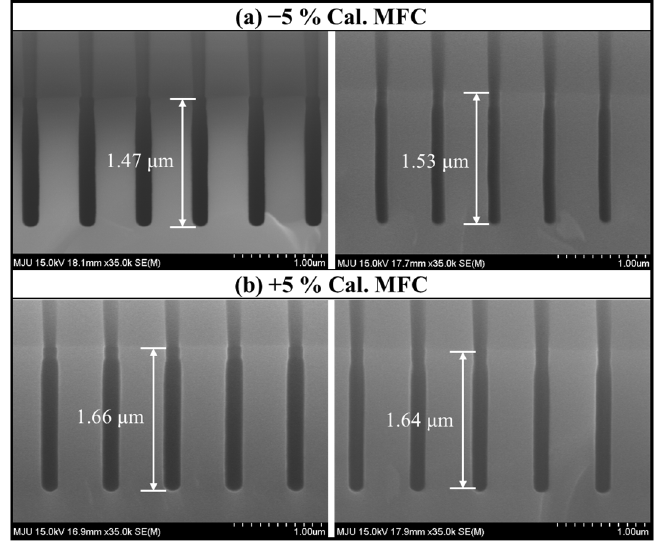
Figure 9. Cross-sectional SEM image of process results with the mis-calibrated MFC; ( a ) results with − 5% calibrated MFC and ( b ) results with +5% calibrated MFC. Most of the normal and abnormal data are acquired in the semiconductor industry.